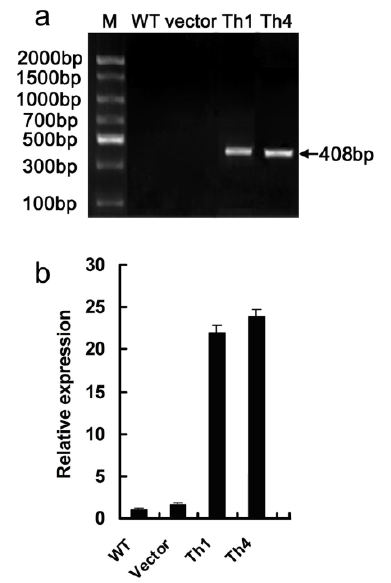
( b ) CgHSP70 transcript abundance as measured by RT-qPCR.